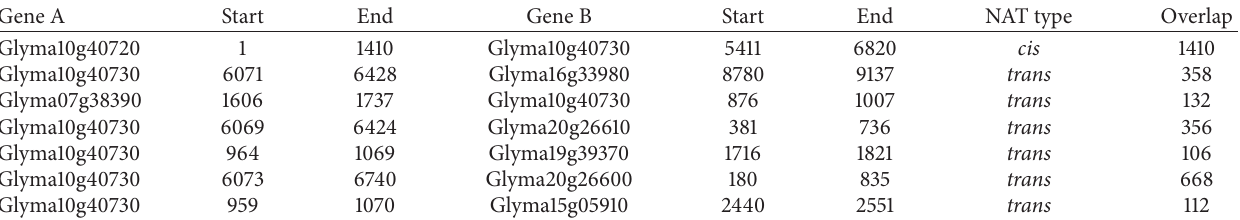
Table 3: NAT pairs ( cis and trans ) involving Glyma10g40730 (as gene A or B), with the overlapping (start-end) covering both sequences, according to